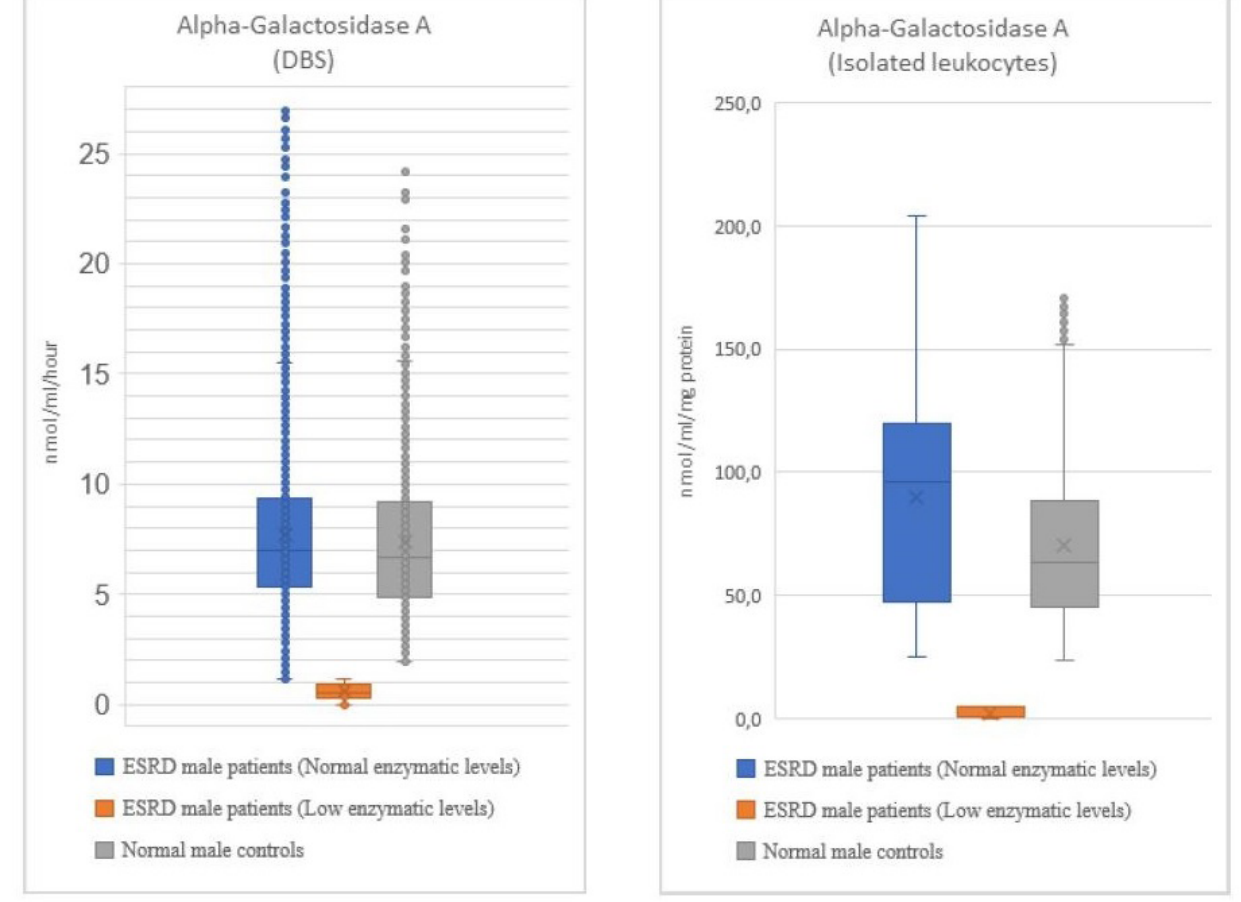
Figure 3. Alpha-galactosidase A levels in ESRD and control male populations studied in DBS (left) and leukocyte extracts (right). In blue is shown the activity of patients with normal enzyme levels, in orange the activity with low enzyme levels and in gray the activity of control males. with a prevalence of 0.23%. Our study is the first report for the frequency of Fabry disease in Colombian ESRD male